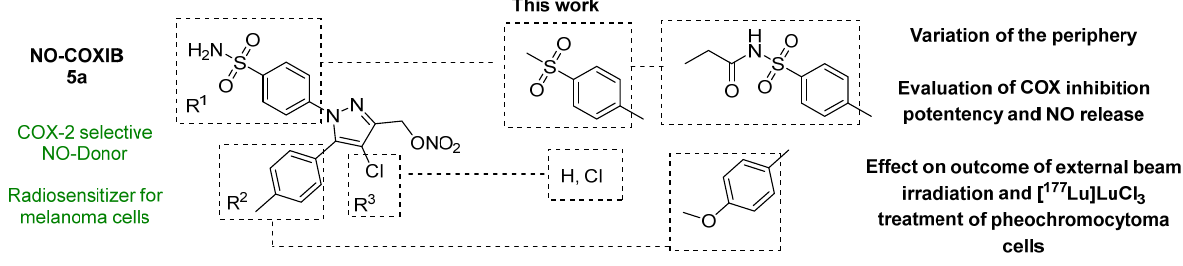
Figure 2. Aim of this